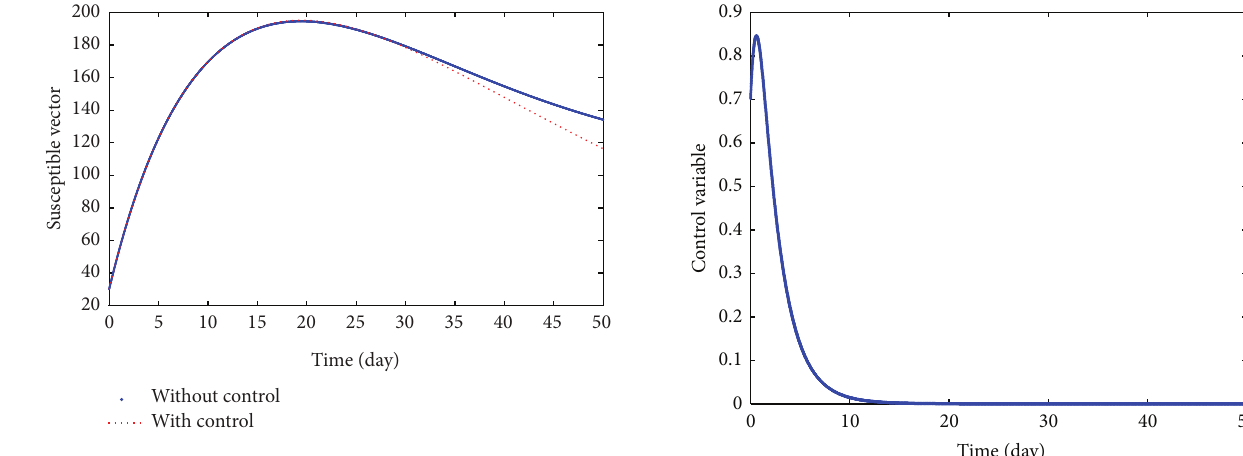
Figure 5: The plot shows the population of susceptible vector with and without control.